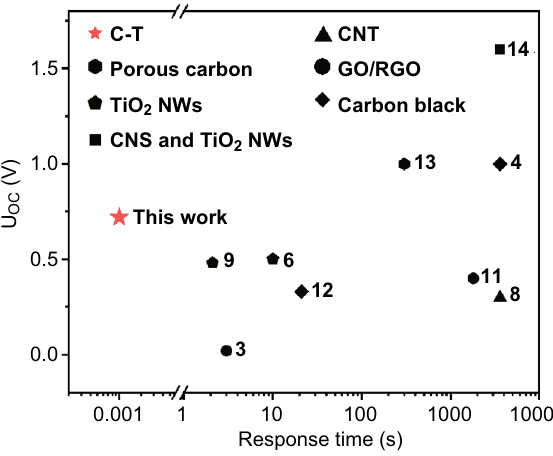
Fig. 5 Comparison of the performance of the C-T power generator with that of other water-induced power generators